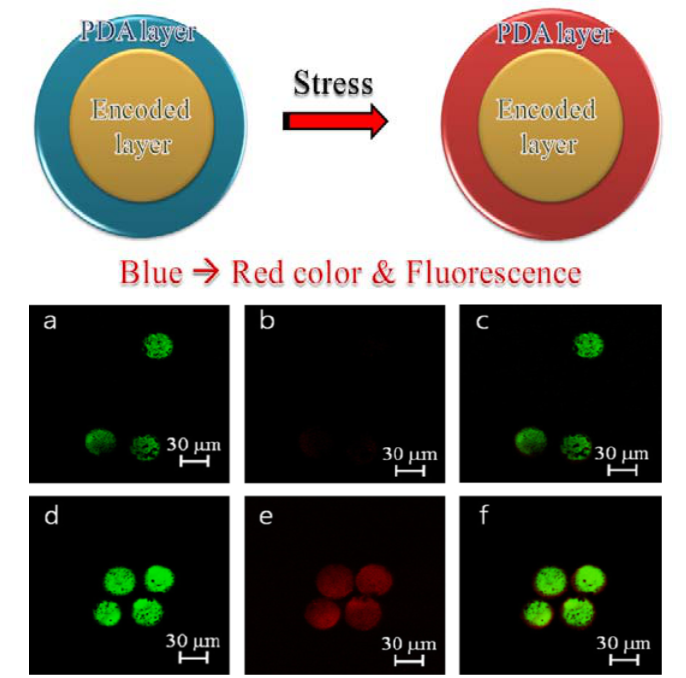
Figure 5. PDA-coated encoded beads. Illustration of PDA-coated encoded beads of before and after stress (upper panel), CLSM images of PDA–FITC encoded beads (lower panel) ( a – c ) unstressed beads and ( d – f ) stressed beads. ( a , d ) at a wavelength of 488 nm; ( b , e ) beads at a wavelength of 543 nm; ( c , f ) at wavelengths of 488 and 543 nm (reproduced with permission from reference [60]. Copyright 2011, Elsevier